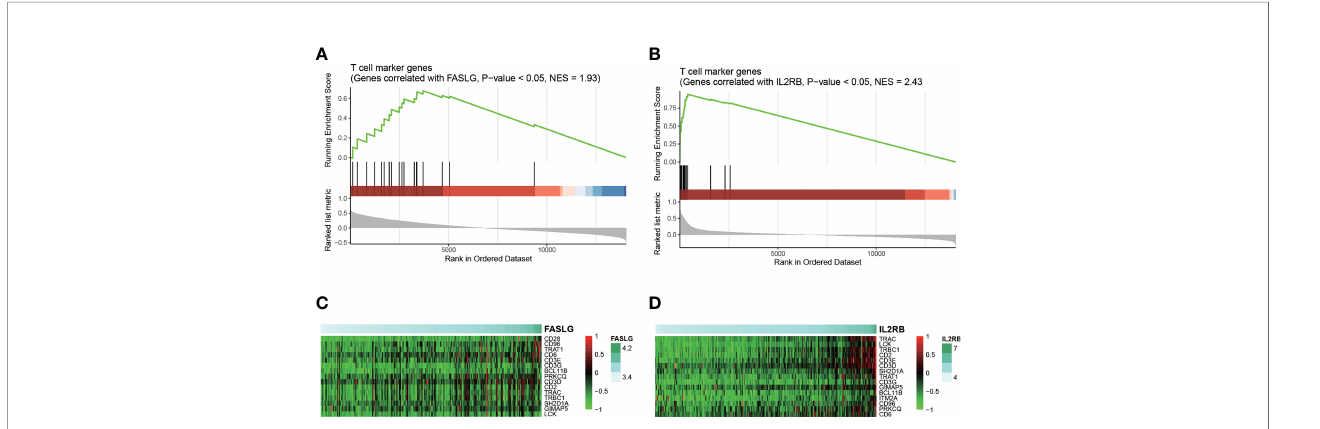
FIGURE 6 | Interpretation of FASLG and IL2RB in HCC recurrence. The statistical signi fi cance of the genes correlated with FASLG and IL2RB enriched in T cell marker genes are displayed in (A, B) , respectively. The heatmaps for the core genes positively correlated FASLG and IL2RB and also speci fi cally expressed in T cell are displayed in (C, D) ,